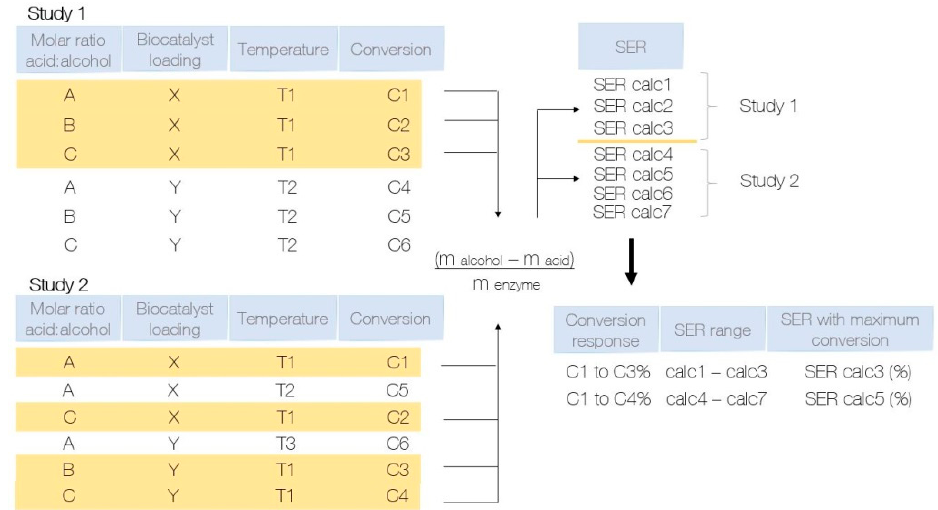
Figure 3. Schematic representation of collecting data from two hypothetical studies of enzymatic ester syntheses for SER calculation and compilation of obtained data.